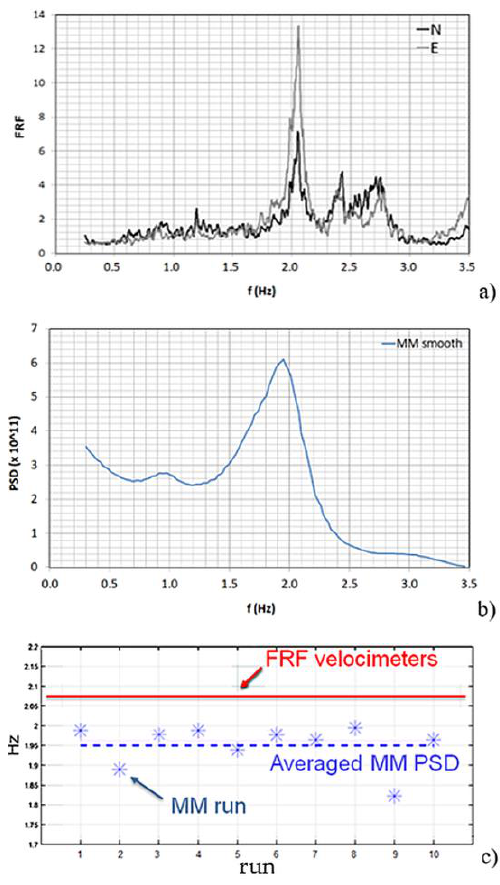
Figure 7. Comparison between MM and seismographs results: ( a ) the fundamental frequency identification by FRF of seismographs; ( b ) smoothed PSD of MM signal; ( c ) MM frequencies by each 10 run and average.